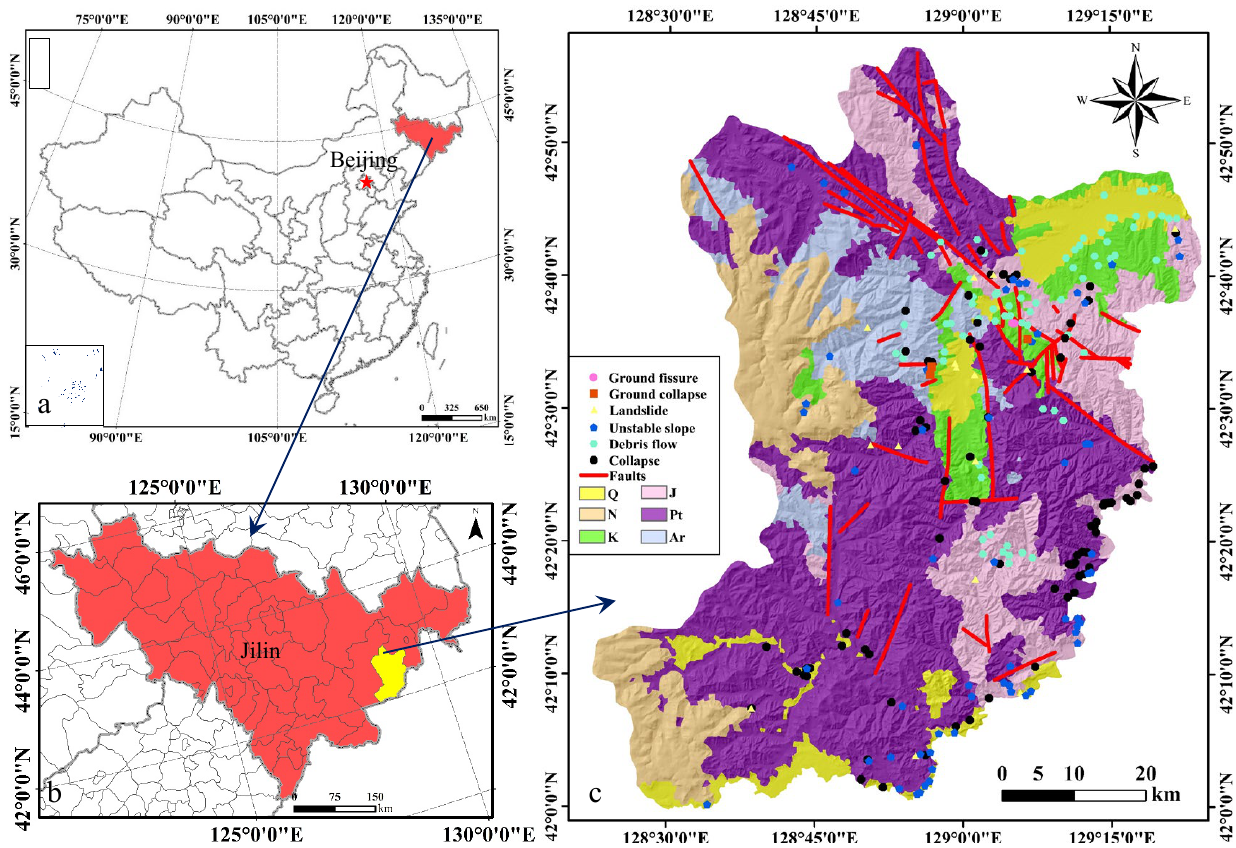
Figure 1. Location of the study area ( a , b ) and geological hazard inventory map and geological map ( c ).